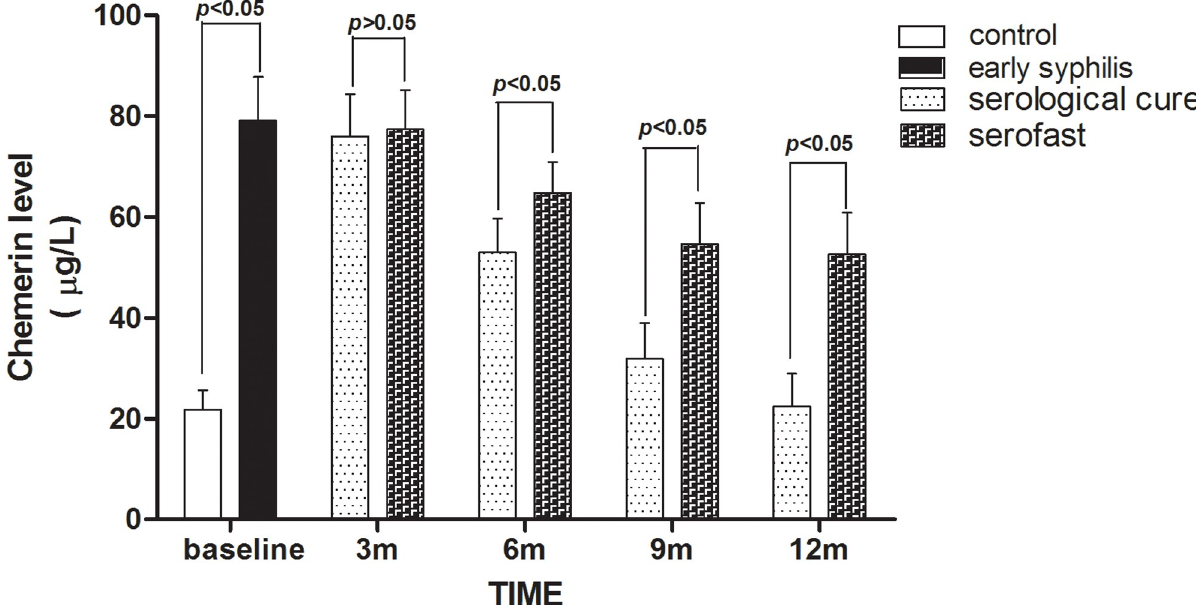
Fig 3. Serum levels of chemerin of early syphilis patient. Detection serum levels of chemerinin control group (n = 30), early syphilis patients (n = 517), serological cure patients (n = 410) and serofast status patients (n = 104). The concentrations of chemerinwere determinedusing a standard curve. Data are shown as the serum concentration of chemerin, and each bar represents the mean ± standard error. Unpaired t-tests was used to assess the significanceof chemerin levels. The control group are healthy uninfectedpatients.